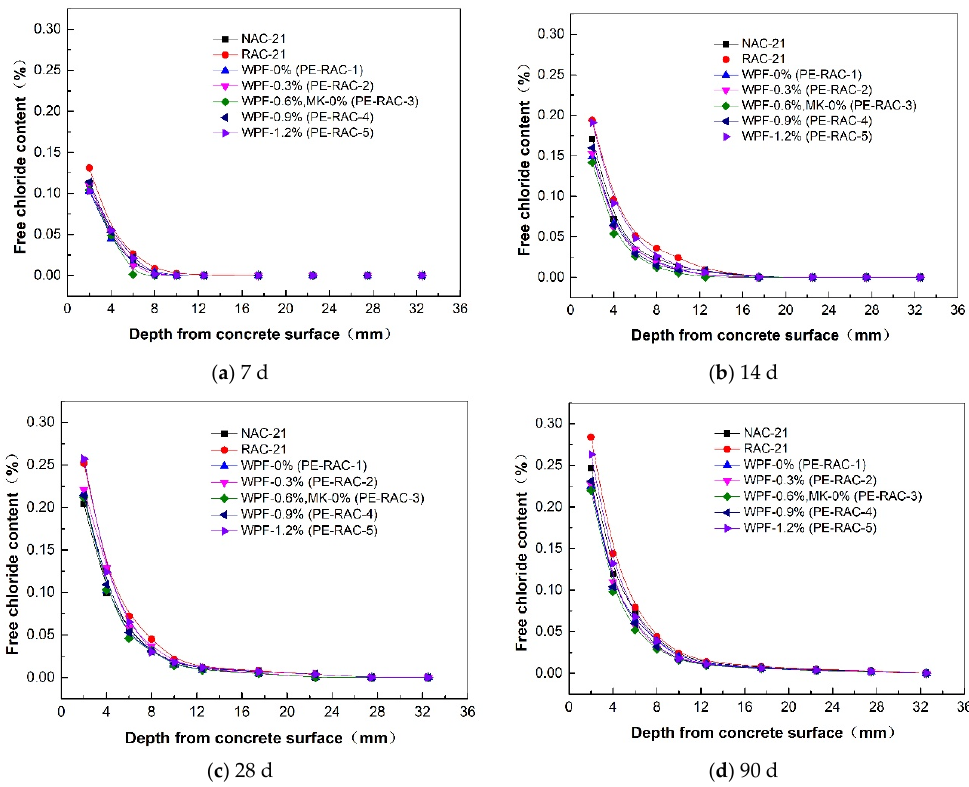
Figure 6. Relationship between free chloride content and salt spray erosion depth.